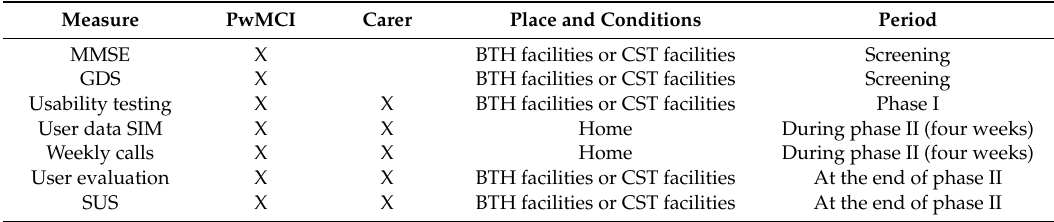
Table 1. List of variables and instruments included in this